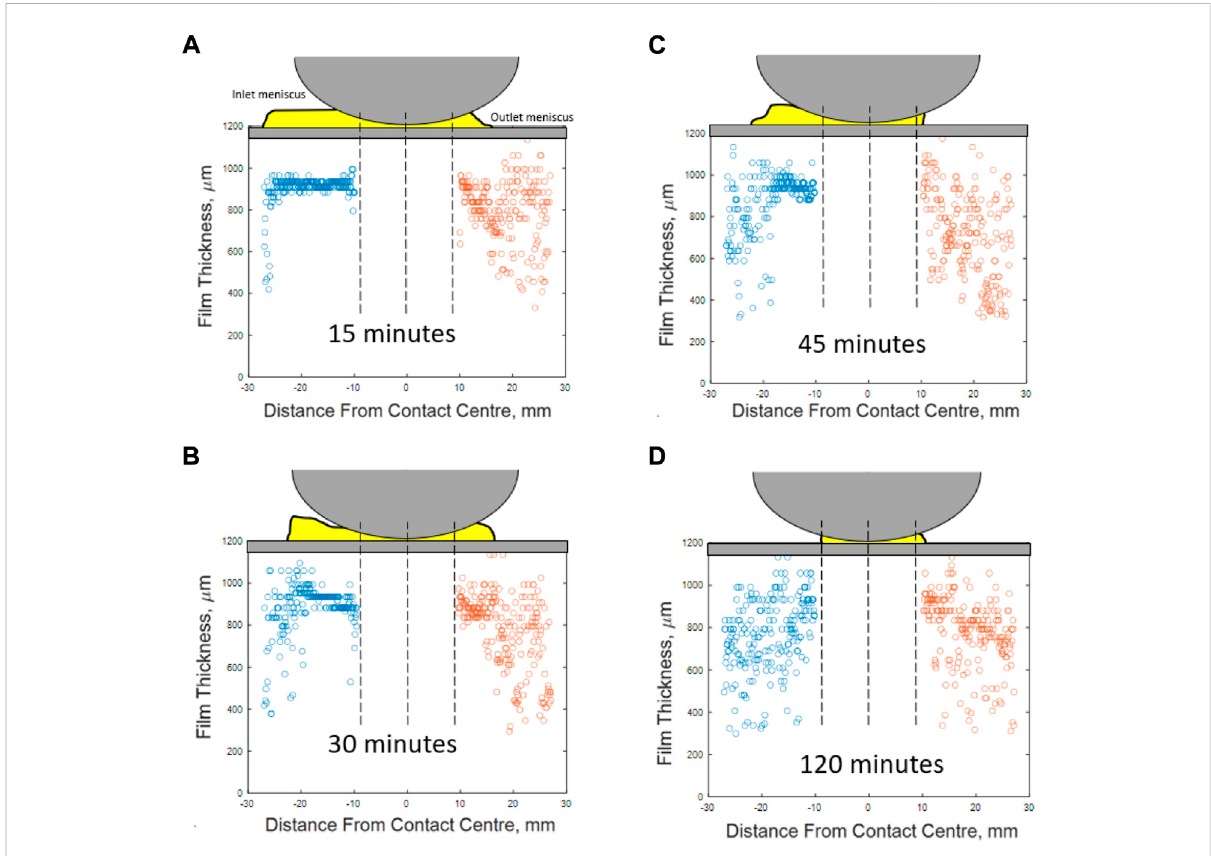
FIGURE 14 Acomparisonofcontactentryandexitmeniscithicknessandlengthfor460WTgreaselubricatedbearingafter (A) 7% (B) 15% (C) 22% (D) 58%of the total churn